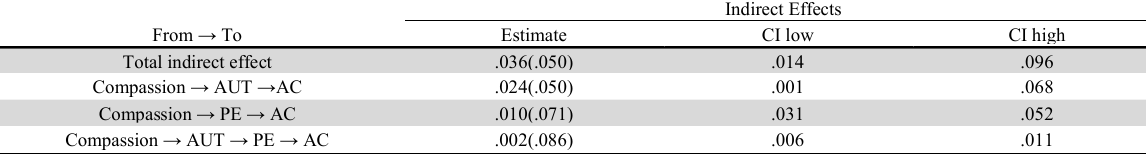
Indirect Effects for the Double-Mediation (Authenticity and Positive Emotion)